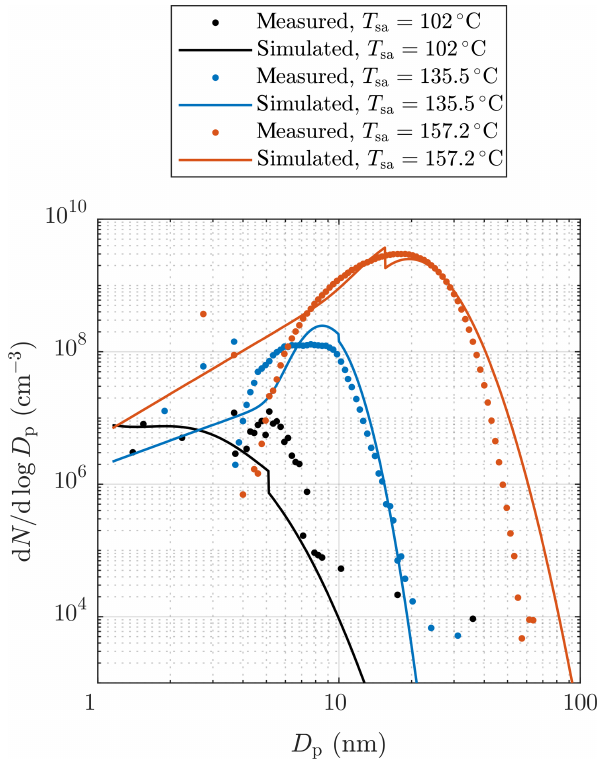
Figure 11. Examples of measured and simulated particle size dis- tributions after the ejector diluter. The measured data are corrected with the dilution ratio of the bridge diluter and with the diffusional losses in the sampling lines after the ejector diluter. Additionally, all concentrations are multiplied by the total dilution ratio of the diluting sampling system. See the Supplement for error bars.